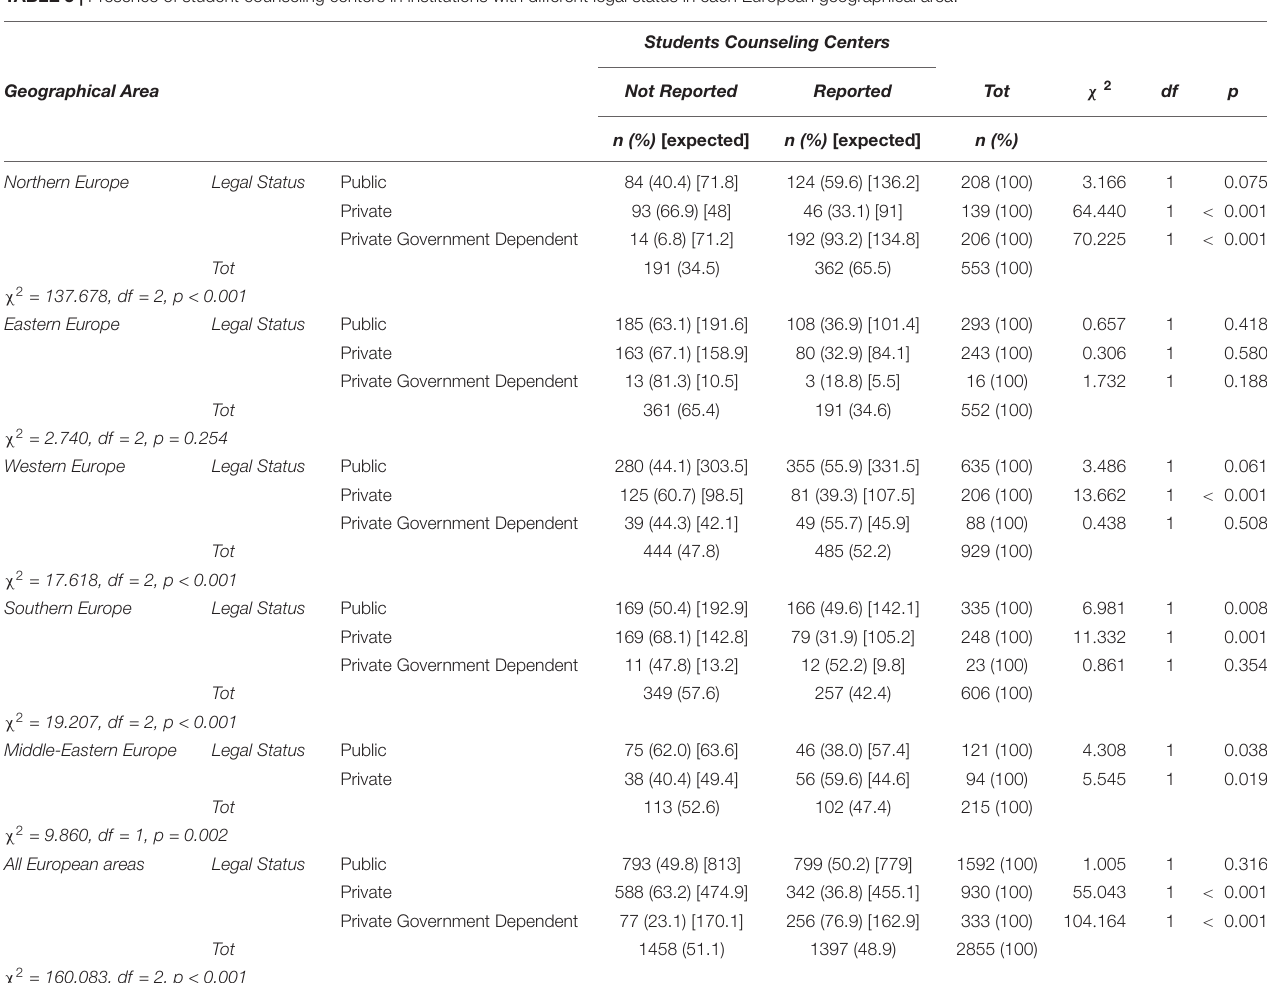
TABLE 5 | Presence of student counseling centers in institutions with different legal status in each European geographical area.